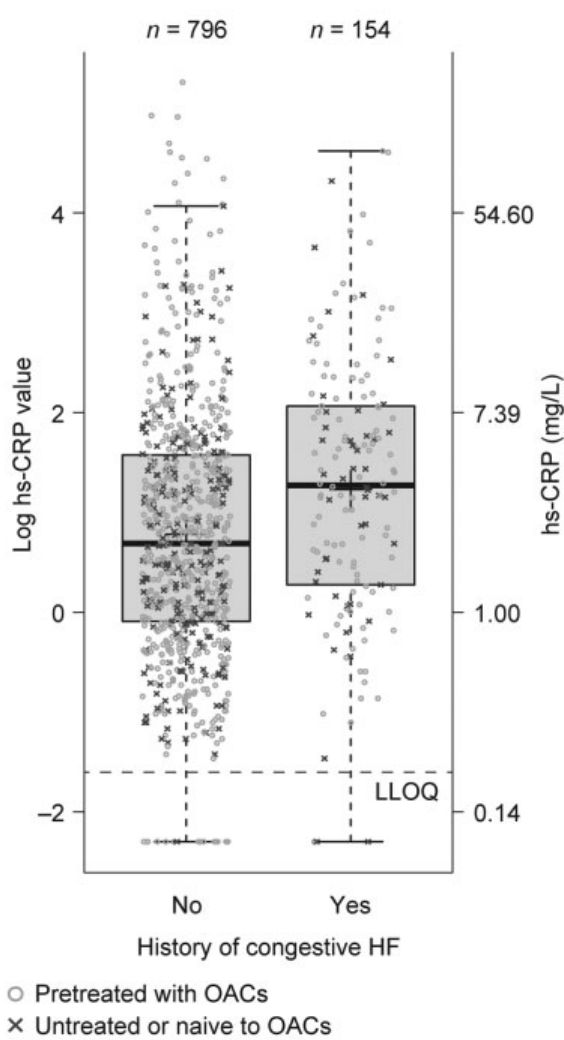
Fig. 3 In fl uence of a history of congestive HF on hs-CRP levels at baseline. HF, heart failure; hs-CRP, high-sensitivity C-reactive protein; LLOQ, lower limit of quanti fi cation; OAC, oral anticoagulant. Note:Upperlinesoftheboxdenotetheupperquartiles,midlinesdenotethe medians and lower lines denote the lower quartiles; crosses denote the geometric means, and upper and lower lines denote maximum and minimum values, excluding outliers (i.e., values that are > 1.5 times the interquartile range further apart from the